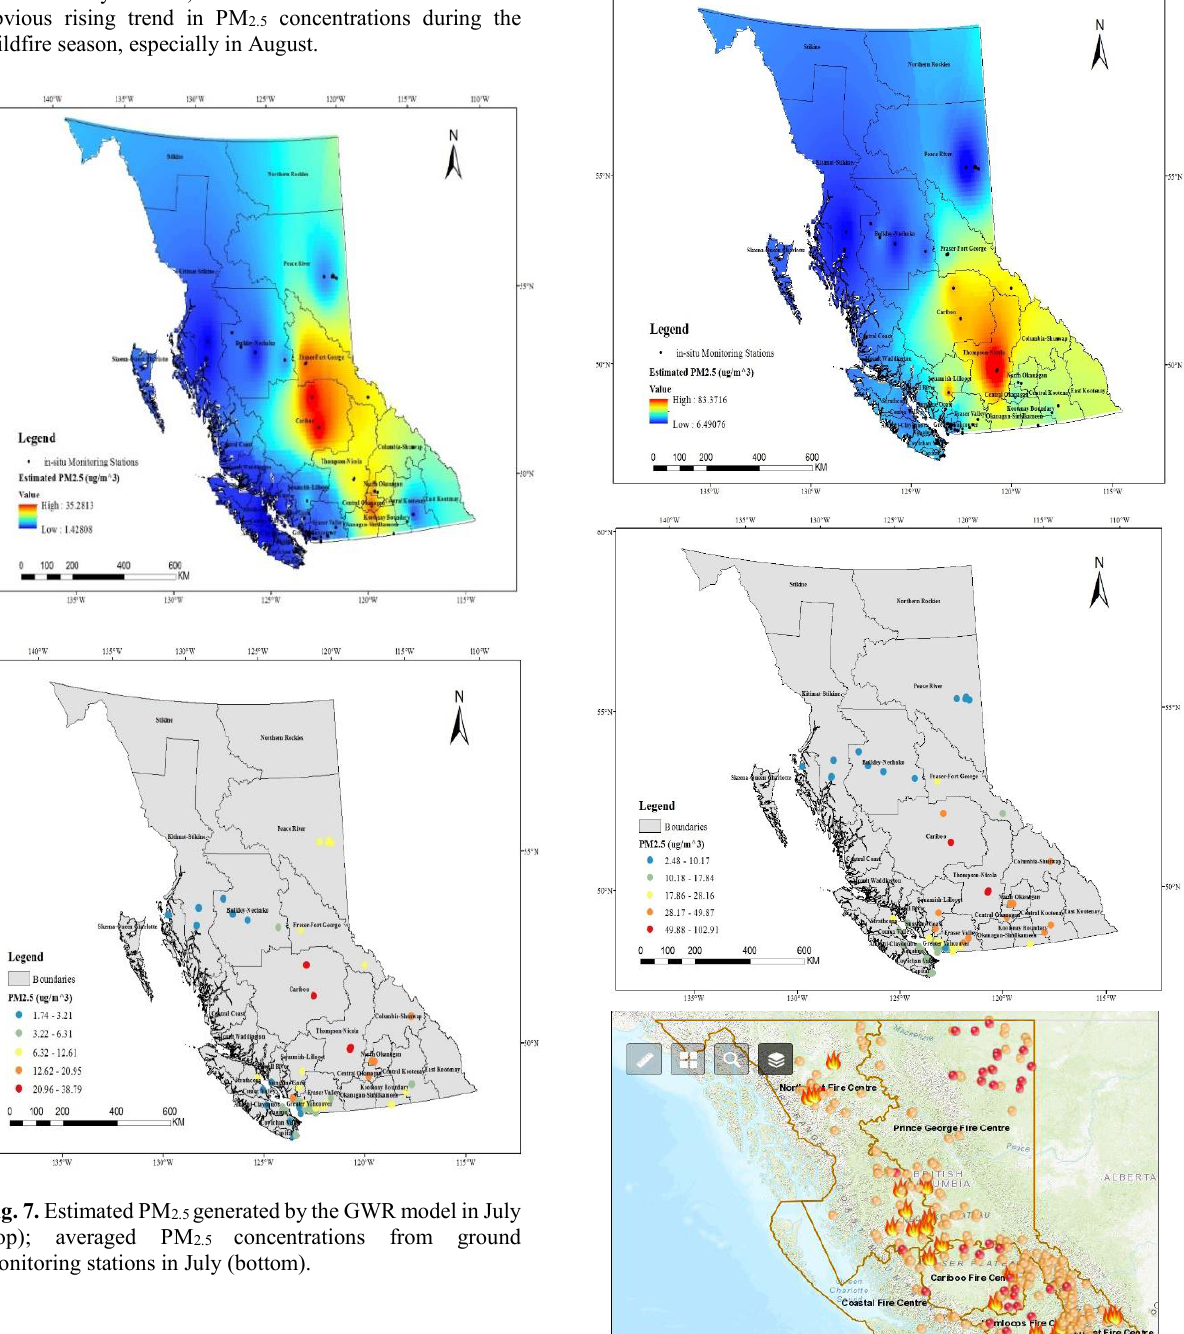
Fig. 8. Estimated PM 2.5 generated by the seasonal GWR model in August (top), averaged PM 2.5 concentrations from ground monitoring stations in August (middle), and British Columbia ’s active wildfire distribution map (bottom) in August